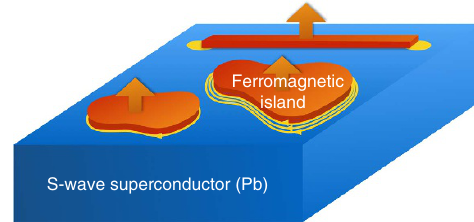
Figure 1 | Topological superconductivity in Shiba lattice systems. A very thin layer of magnetic adatoms, such as Fe or Co, is deposited on the surface of a conventional s -wave superconductor with strong spin-orbit coupling, such as Pb, and forms a one-dimensional chain or a two-dimensional island that is ferromagnetically ordered (represented by the upward arrows). The resultant lattice of magnetic-impurity-induced bound states, or Shiba lattice, generically bears chiral topological superconductivity and the associated chiral Majorana boundary modes (represented by yellow dots or lines with unidirectional arrows). In two dimensions, one or many Majorana modes may appear depending on the density of the magnetic adatoms. These modes can be detected by tunneling